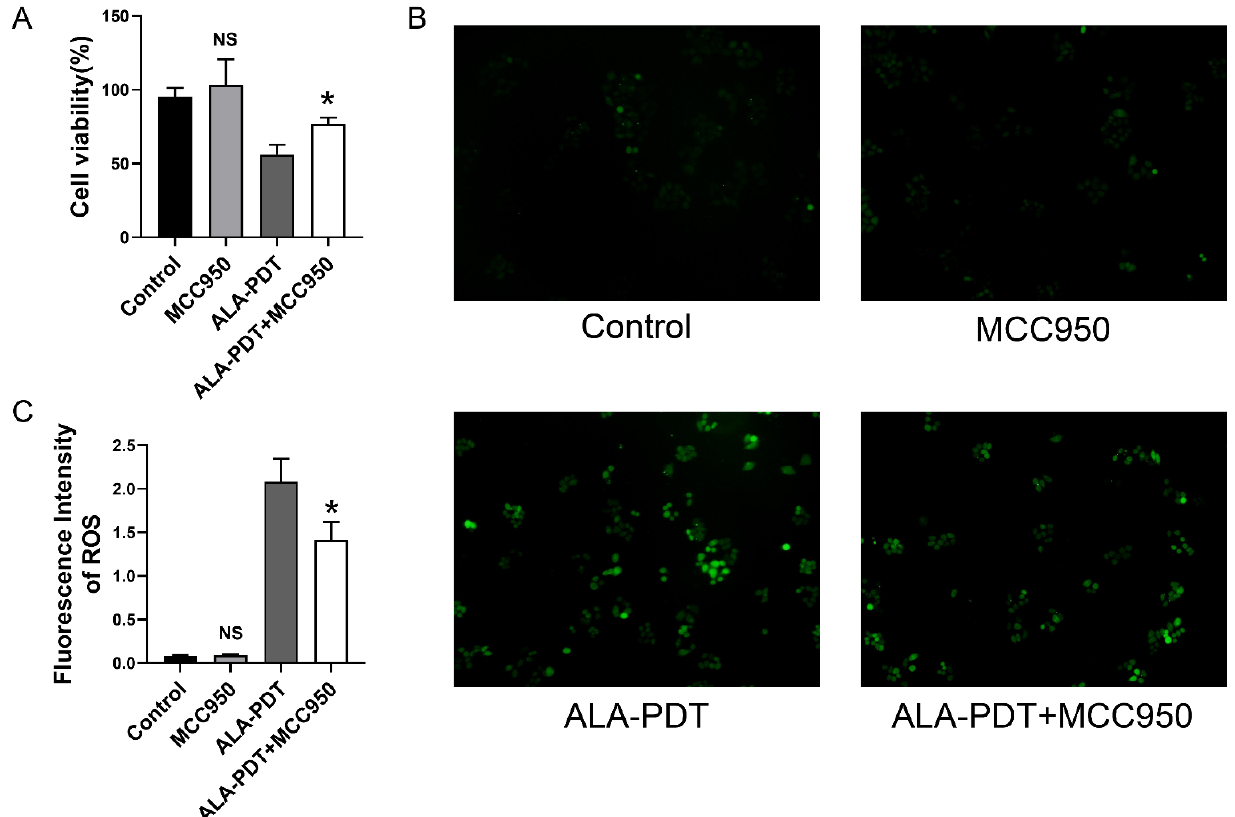
Figure 5. MCC950 suppressed ALA-PDT-induced cell death and ROS production. ( A ) CCK-8 assay for cell toxicity. NS: p > 0.05 compared with the control group. * p < 0.05 compared with ALA-PDT group. ( B ) The green fluorescence of ROS (100×). ( C ) Statistical analysis of the fluorescence intensity of ROS. NS: p > 0.05 compared with the control group. * p < 0.05 compared with ALA-PDT group.